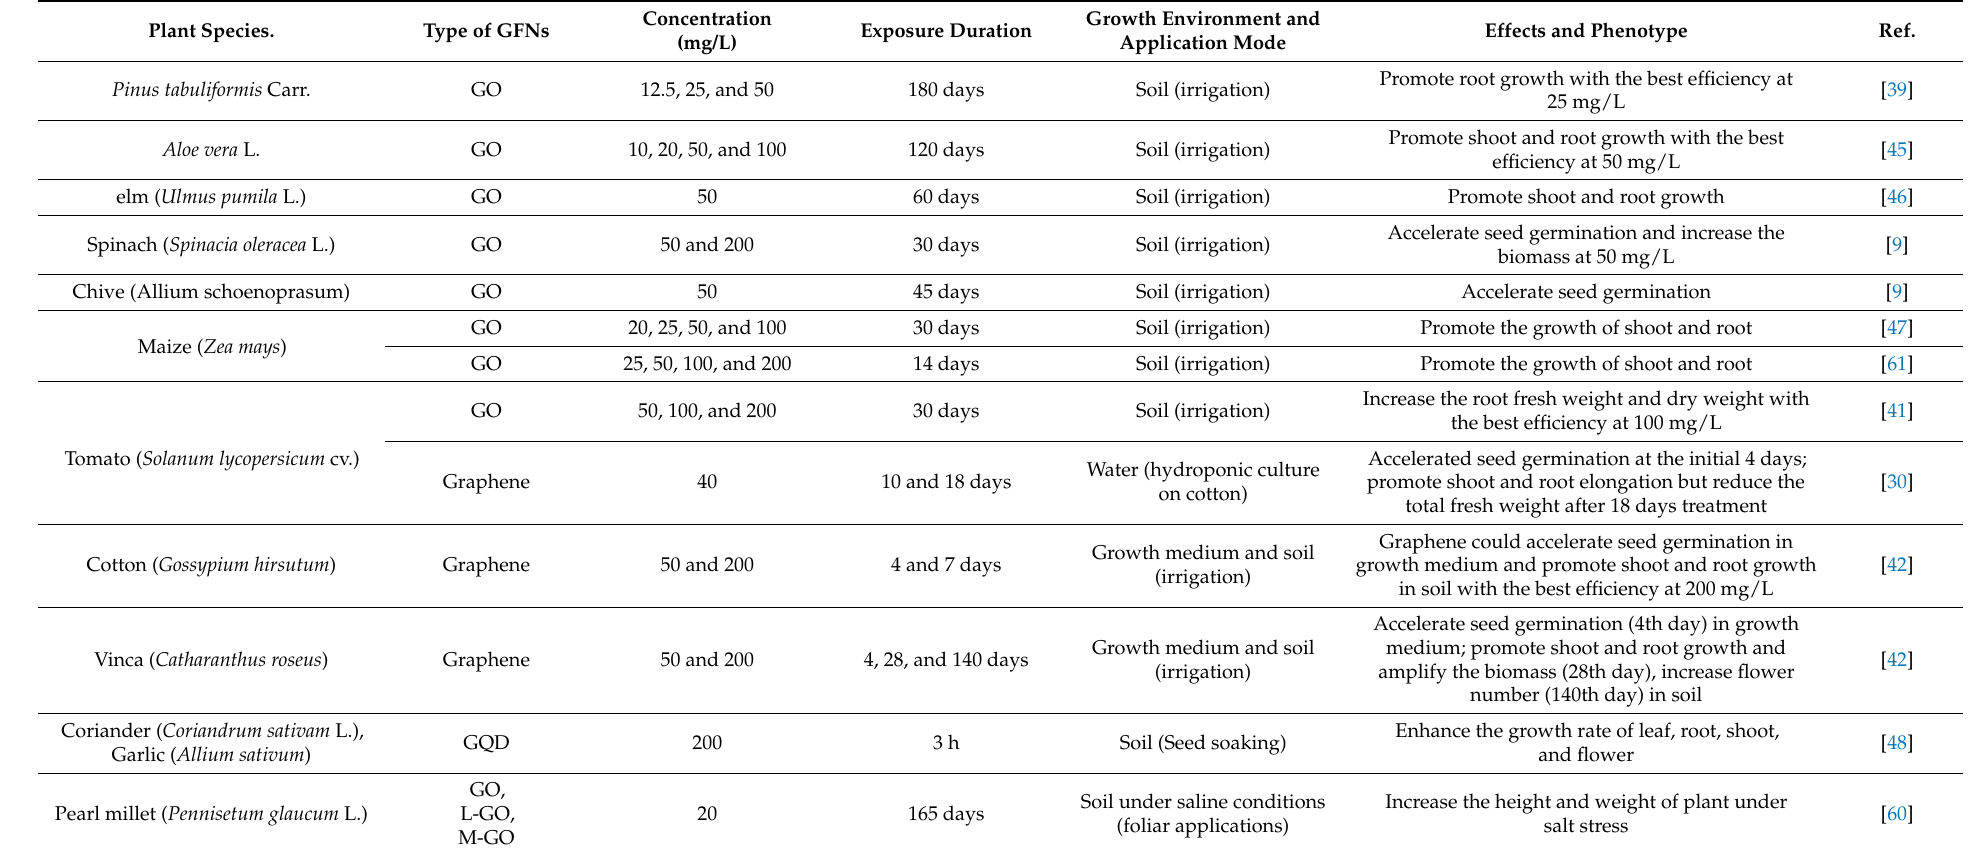
Table 1. Positive effects of graphene-family nanomaterials (GFNs) in